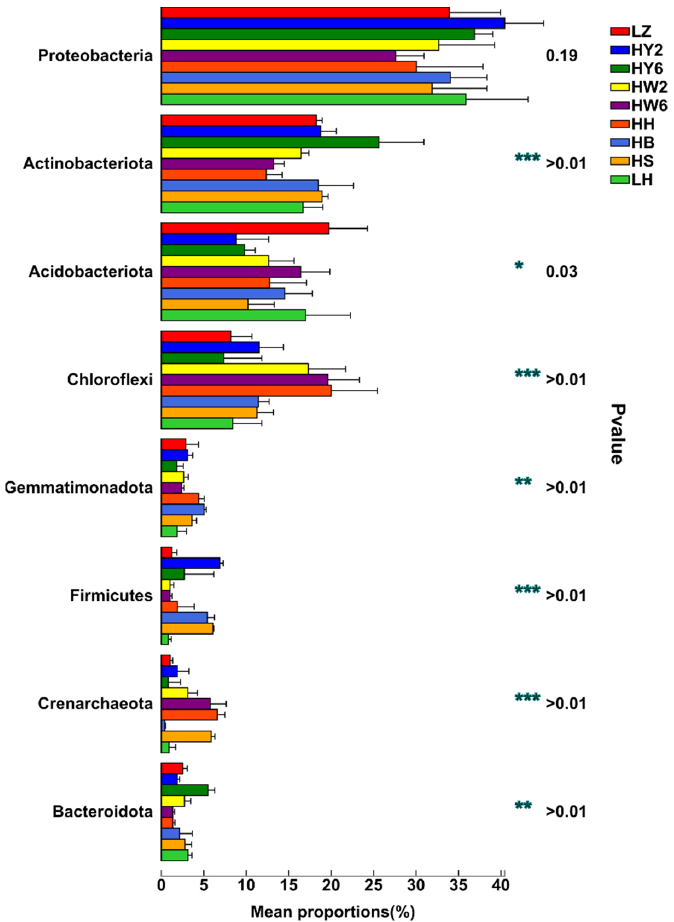
Figure 4. Multiple comparisons of soil bacterial community at the phylum level. LZ, HY2, HY6, HW2, HW6, HH, HB, HS, and LH; continuous cropping of C. chinensis for 5 years, maize continuous cropping for 2 years, maize continuous cropping for 6 years, P. multiflorum continuous cropping for 2 years, P. multiflorum continuous cropping for 6 years, sweet potato continuous cropping for 2 years, F. thunbergia continuous cropping for 2 years, cabbage continuous cropping for 2 years, and fallow field, respectively.